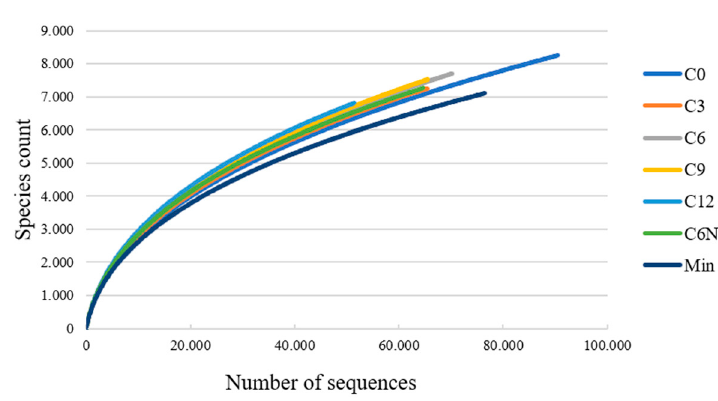
Figure 4. Rarefaction curves of the complete dataset of sequences. C0, unfertilized soil; C3, C6, C9 and C12 = 3, 6, 9 and 12 Mg / ha sewage sludge compost, respectively; C6N, combined application of 6 Mg / ha of sewage sludge and 60 kg / ha N; Min, mineral fertilization.